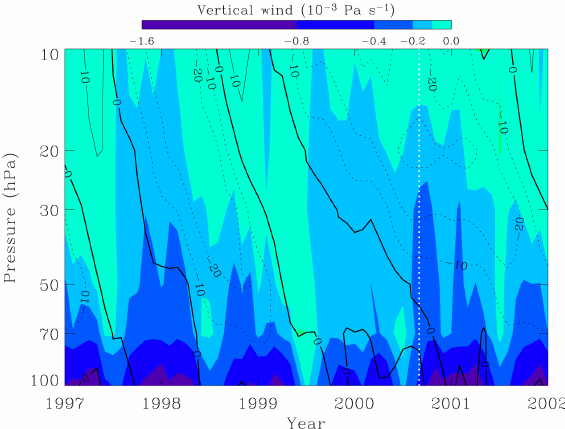
Figure 11. Time–height section of the zonally and latitudinally (within 15 ◦ N and S) averaged monthly mean vertical (color, 10 − 3 Pas − 1 ) and zonal (contour, ms − 1 ) wind velocities from Jan- uary 1997 to December 2001 calculated from the ERA-Interim data set. Solid (dashed) contours are westerlies (easterlies). Tick marks are January of the corresponding year, and the vertical dashed line in white marks September 2000.